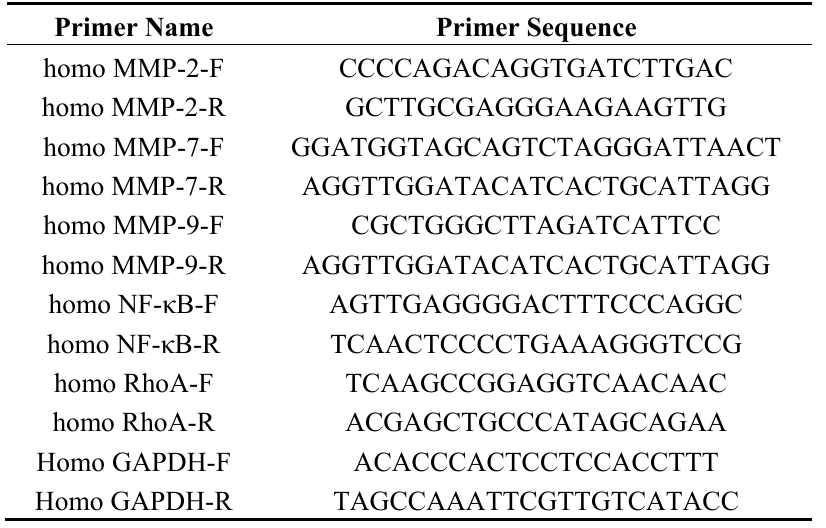
Table 1. The DNA sequence was evaluated using the Primer